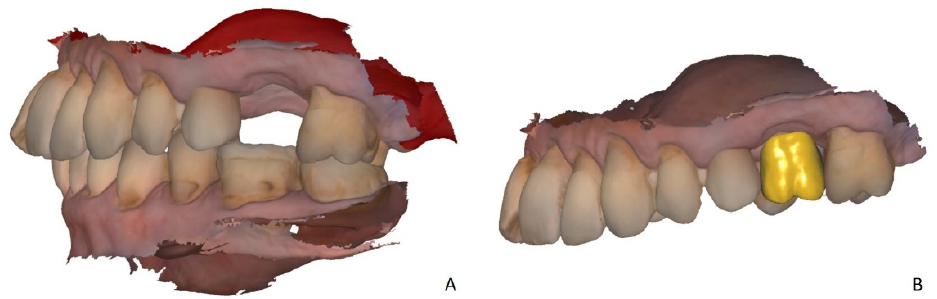
Figure 1. ( A ) The virtual model of the defect obtained with the intraoral scanner (Trios 4, 3Shape, Copenhagen, Denmark). ( B ) The virtual set-up of the pontic tooth in the CAD software (Dental CAD, Exocad, Darmstadt, Germany) with a 2 mm distance to the alveolar ridge.